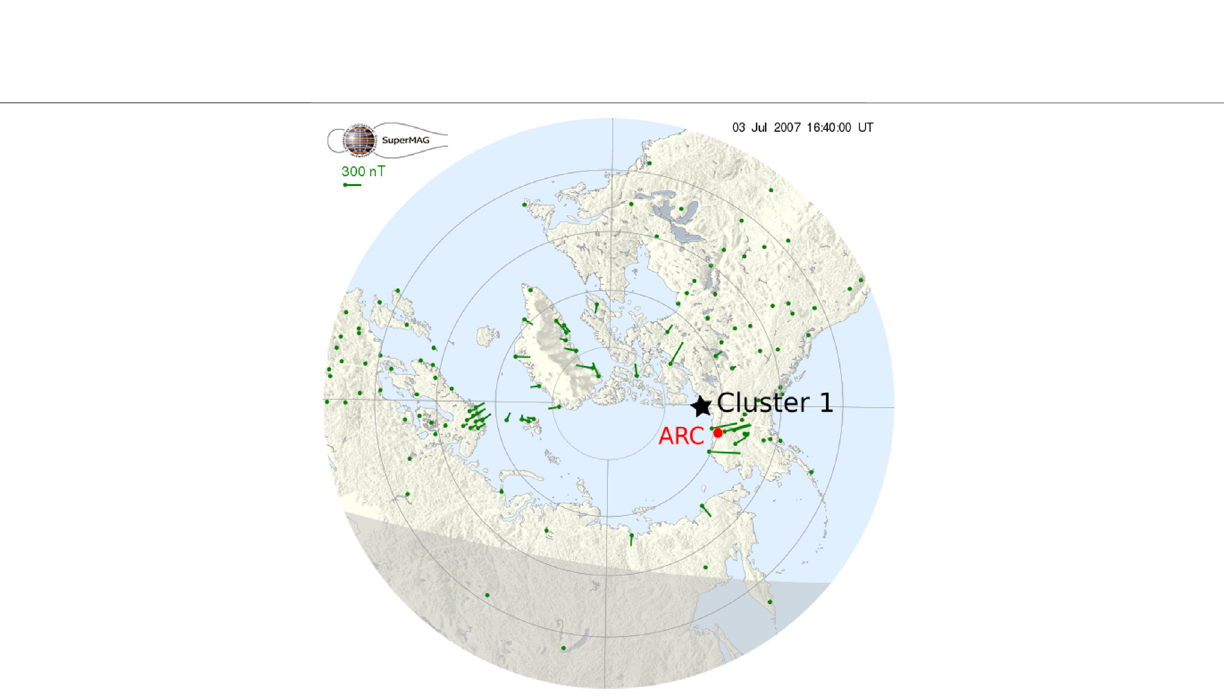
Frontiers in Physics |